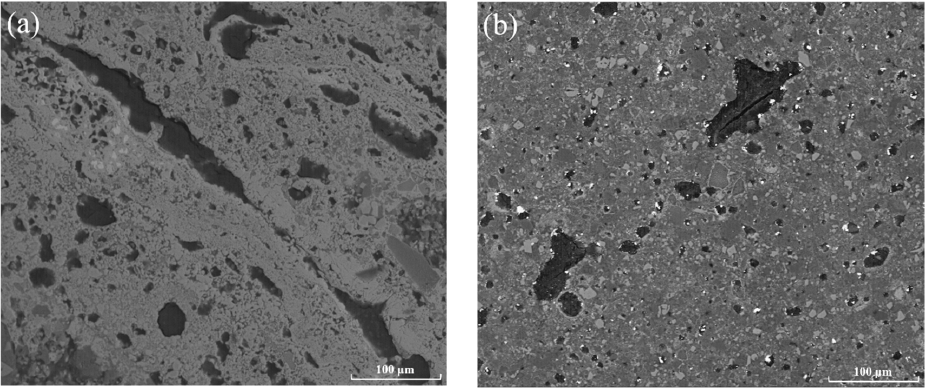
Figure 9. SEM images of ceramic tiles with Fe/Cr = 2.0 sintered at different temperatures for 30 min ( a ) 1100 °C and ( b ) 1150 °C.